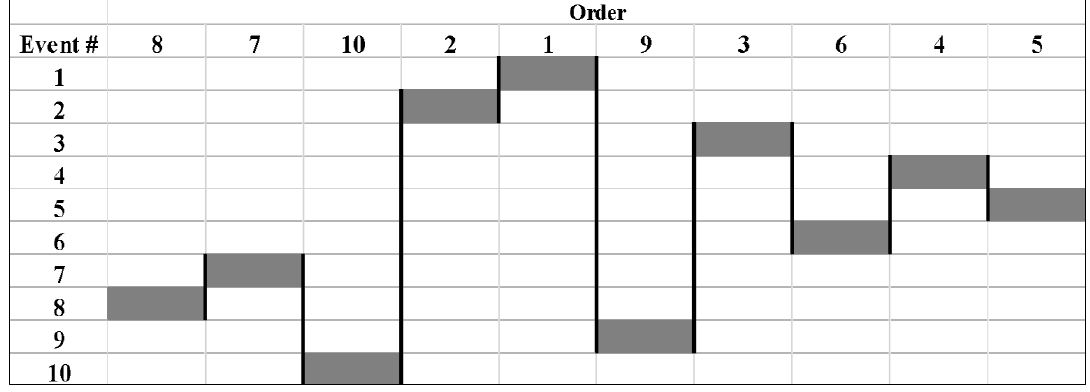
Figure 11. Basic lazy serpent schedule.